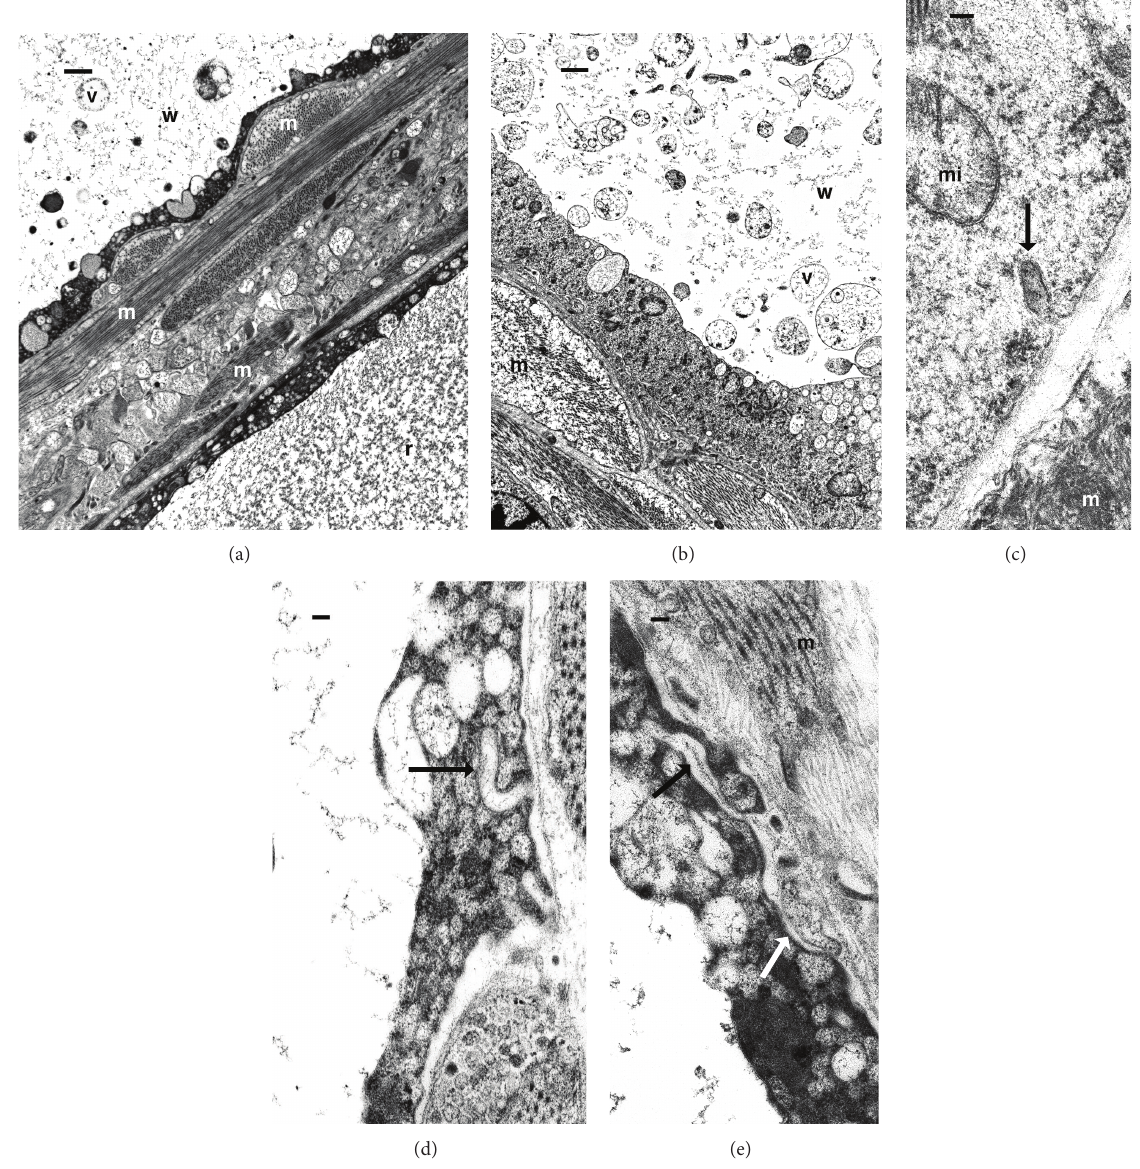
Figure 6: White and purple vesicles of Aplysia parvula . (a) Adjacent white (lumen filled with vacuoles and filamentous material) and purple (lumen of electron dense, granulate material) vesicles separated by muscle. (b) White vesicle with peripheral cytoplasmic layer surrounding a lumen filled with low electron dense, filamentous material and small vacuoles. ((c)–(e)) The cell membrane of white vesicles is infolded (arrows) into the peripheral cytoplasmic layer and these invaginations contain low electron dense, filamentous material. m, muscle; mi, mitochondrion; r, purple vesicle; v, vacuole; w, white vesicle. Scale bars: (a) and (b) = 1 𝜇 m; (c)–(e) =